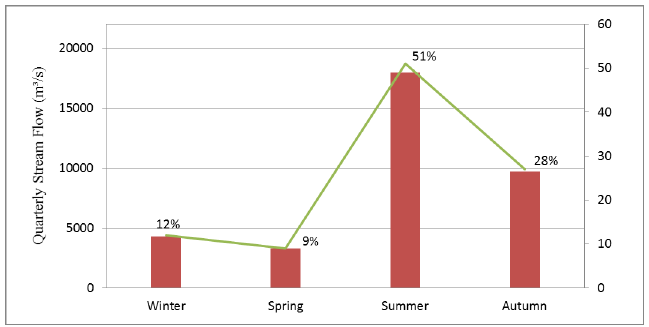
Fig 7. Quarterly streamflow distribution at Nuxia in 2050 (the averageof 3 RCP